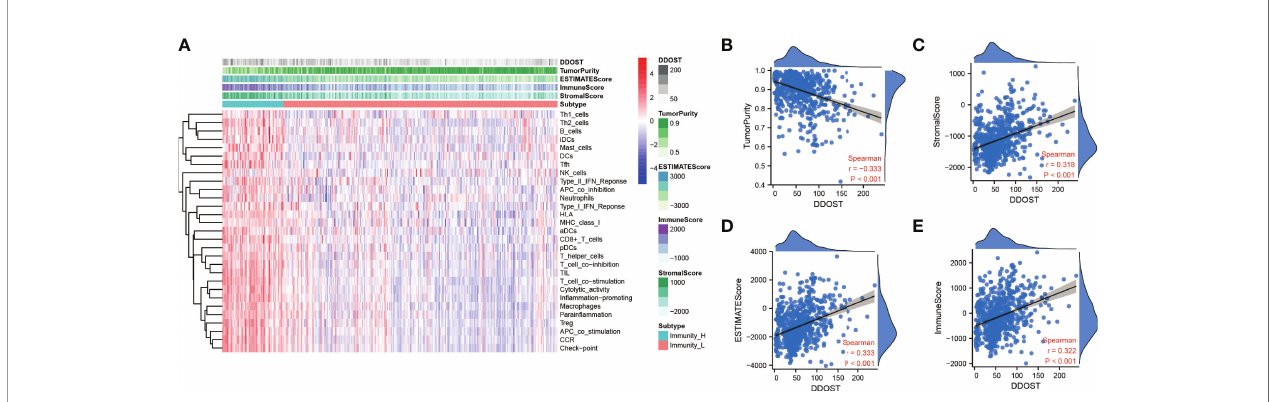
FIGURE 8 | Immune in fi ltration patterns of low- and high-DDOST analyzed by ssGSEA methods in glioma from the CGGA dataset. (A) Heatmap revealing the scores of immune cells in low and high immunities. (B – E) Scatter plot showing the correlation between DDOST and tumor purity, stromal, ESTIMATE, and immune